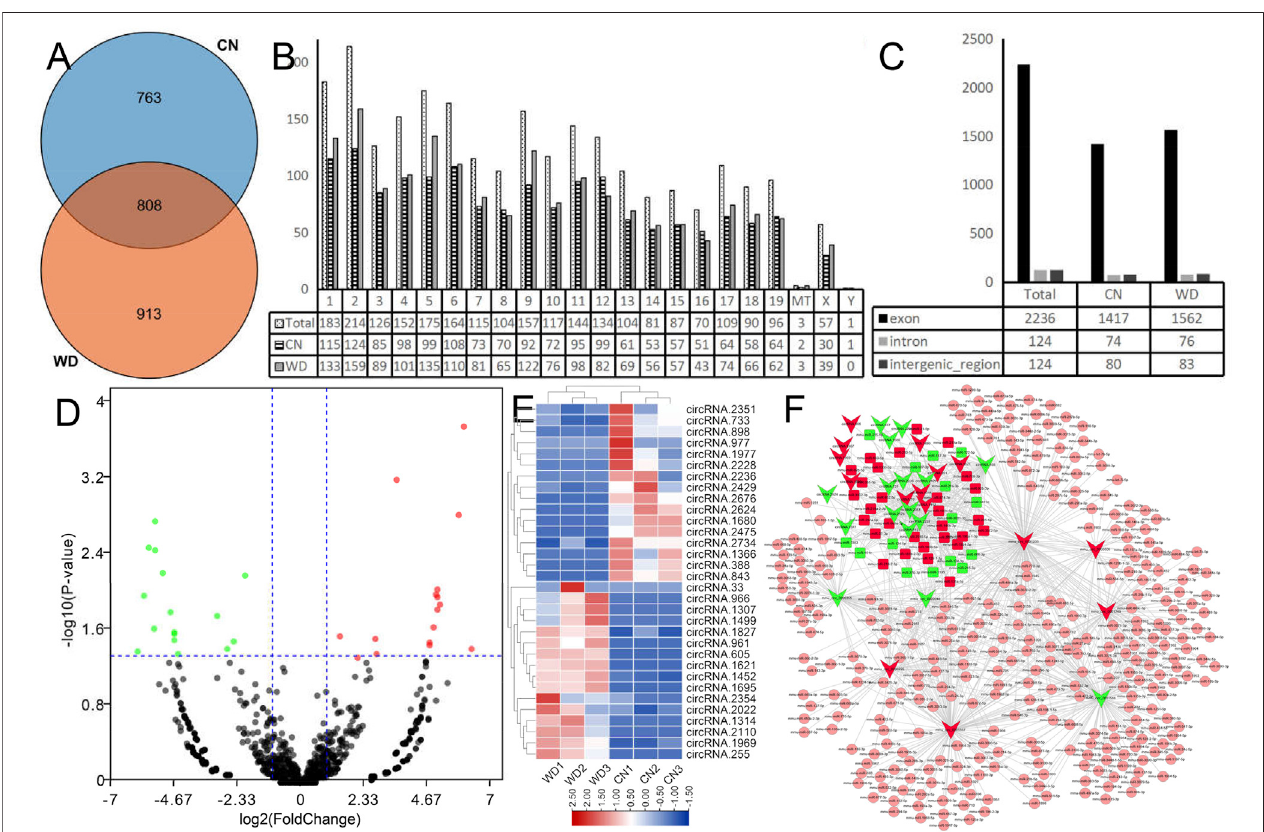
FIGURE 5 | Landscape of circRNAs in WD mouse kidneys. (A) The Venn plot of circRNAs in the WD and CN groups. (B) Bar diagram showing the distribution of circRNAs in mouse chromosomes. (C) Bar diagram showing the different categories of circRNAs. (D) DecircRs displayed on a volcano plot. Blue and red indicate > two foldsofdecrease and increase in expression, respectively ( p < 0.05). Gray indicates no signi fi cantdifference. (E) DEcircRs displayed via hierarchicalclustering; numbers indicatethesamplesusedforRNA-seq. (F) DEcircRs-miRNAnetworkconstructedusingDEcircRsandDEmiRsthatwereidenti fi edusingRNA-seqandsRNA-seq. Red nodes indicate upregulated RNAs and green nodes downregulated RNAs. Square nodes represent miRNAs. V-shaped nodes represent circRNAs. Pink nodes indicate no signi fi cant difference in miRNA expression.